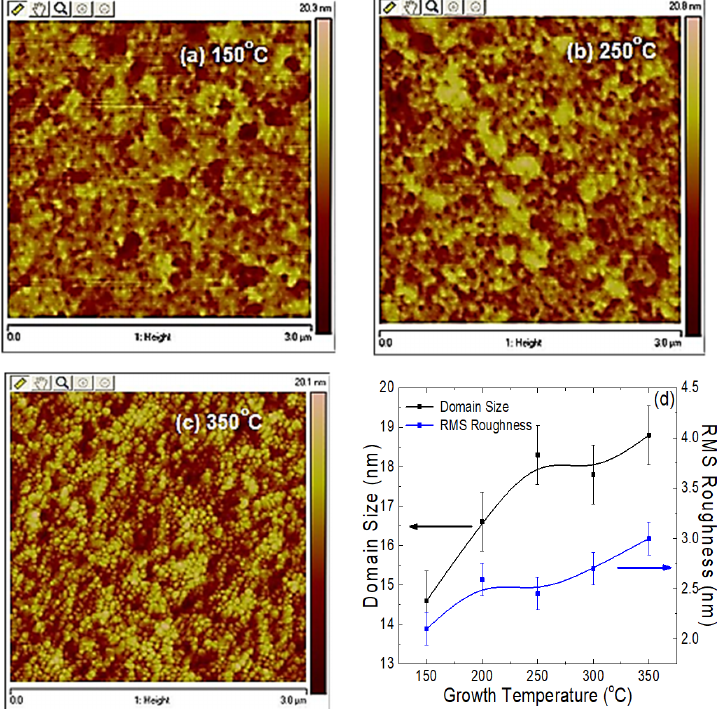
Figure 2. AFM images of the CdSe thin films surface grown at ( a ) 150 °C, ( b ) 250 °C, and ( c ) 350 °C. ( d ) Growth temperature dependent grain size and surface roughness analysis for the CdSe thin films deposited at different growth temperatures. Solid lines are a guide for the eyes.